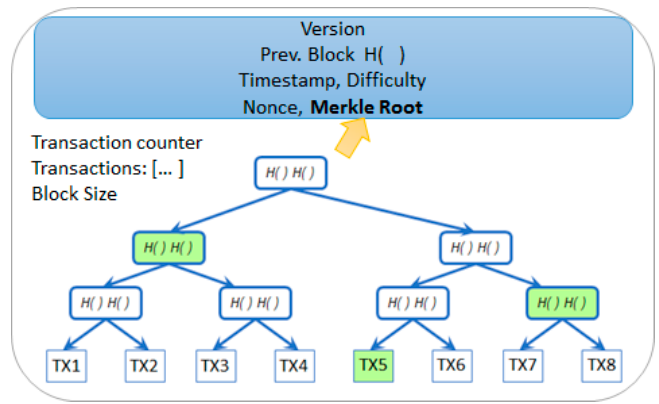
Figure 1. Merkle Tree for storing multiple energy transactions (TX) in a block and Merkle Path